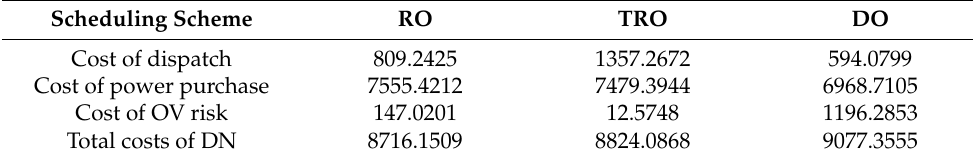
Table 5. Distribution network operating cost parameters for different scheduling